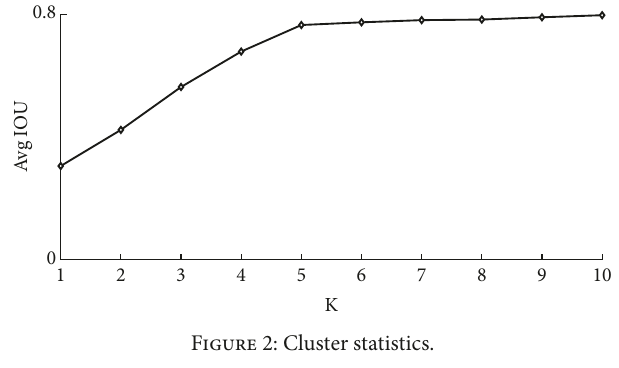
Figure 2: Cluster